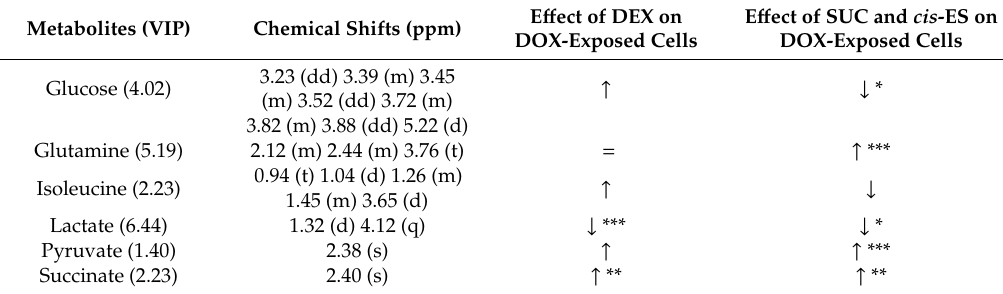
Table 2. Identified discriminant metabolites for the extracellular compartments, with the corresponding chemical shifts.